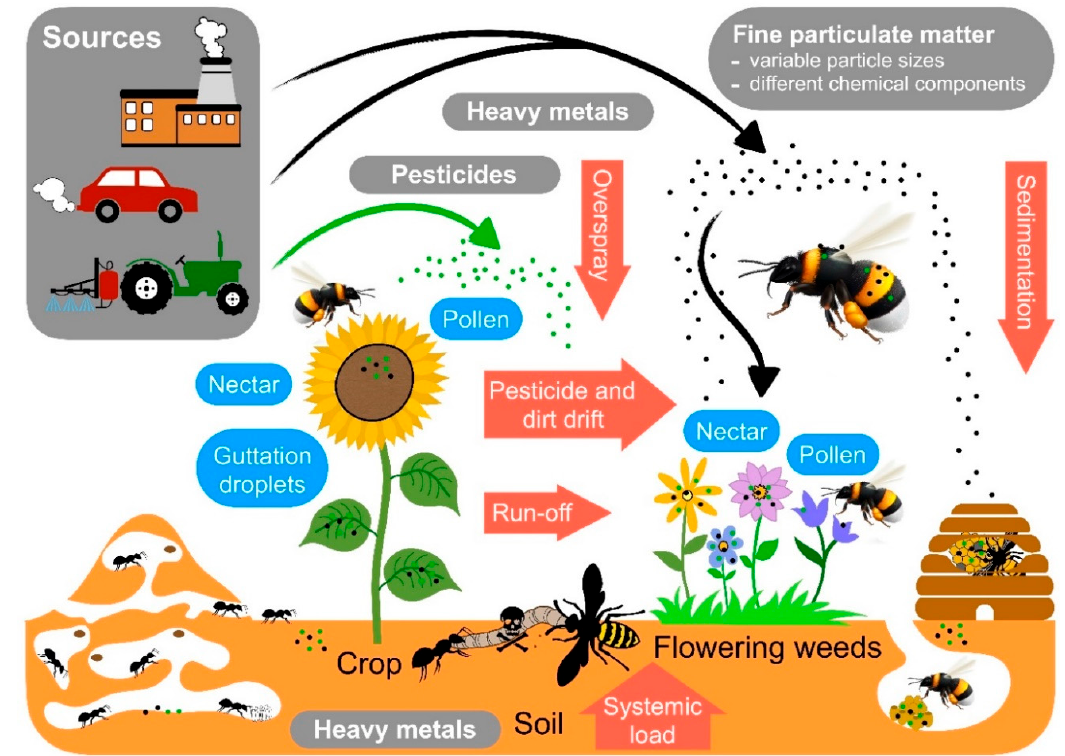
Figure 1. Sources of the environmental pollutants and exposure pathways of social insects to pollutants. Pesticides (including insecticides) derive mostly from agricultural sources, while heavy metals are released into the environment through industrial processes, combustion, or traffic. Fine particulate matter includes both, pesticides (or their residues) and heavy metals bound to particles of 10µm and smaller. Fine particulate matter is composed of many different potentially toxic chemical components. Social insects can take up pollutants orally during foraging and then transfer them to the brood or incorporate them into nest material. In bees, pollutants can also end up in stored food, such as honey or bee bread. In addition, pollutants may be deposited on the cuticles of insects and their nests directly via the air. Subsequently, these may again be incorporated into nest material or even enter the insect’s body, e.g., via the tracheal system.